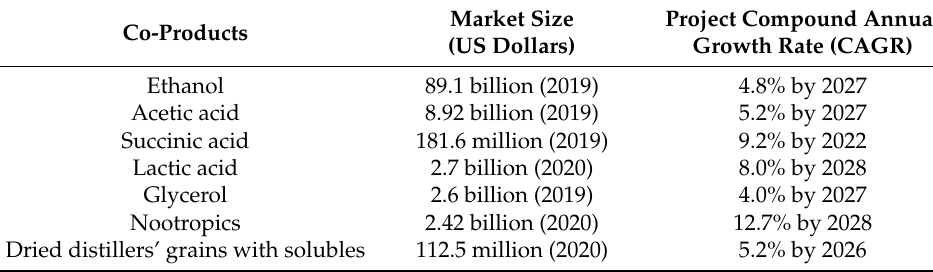
Table 1. Market size of coproduct solutes from alcoholic fermentation